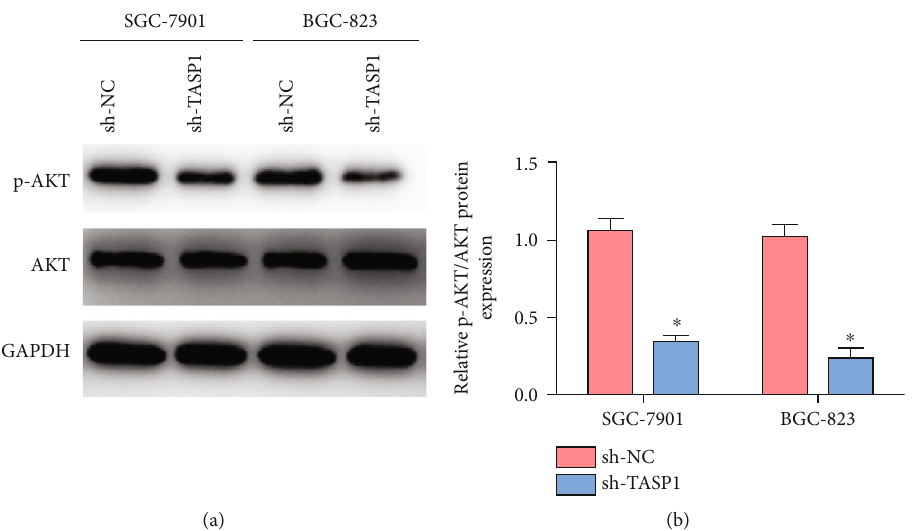
Figure 4: TASP1 promotes the phosphorylation of AKT in GC cells. (a) Western blot detected the expressions of AKT and p-AKT in GC cells transfected with sh-TASP1. (b) The relative p-AKT/AKT protein expression in GC cells transfected with